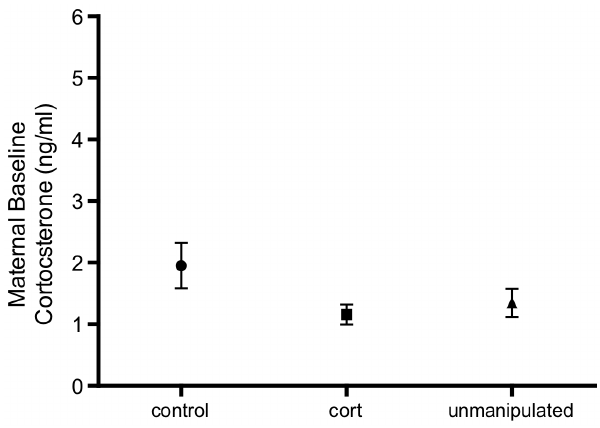
Figure 5. Maternal baseline CORT between experimental treatments. CORT: mothers fed CORT spiked mealworms during egg laying ( n =15), Control: mothers fed mealworms ( n =13) and un- manipulated mothers ( n